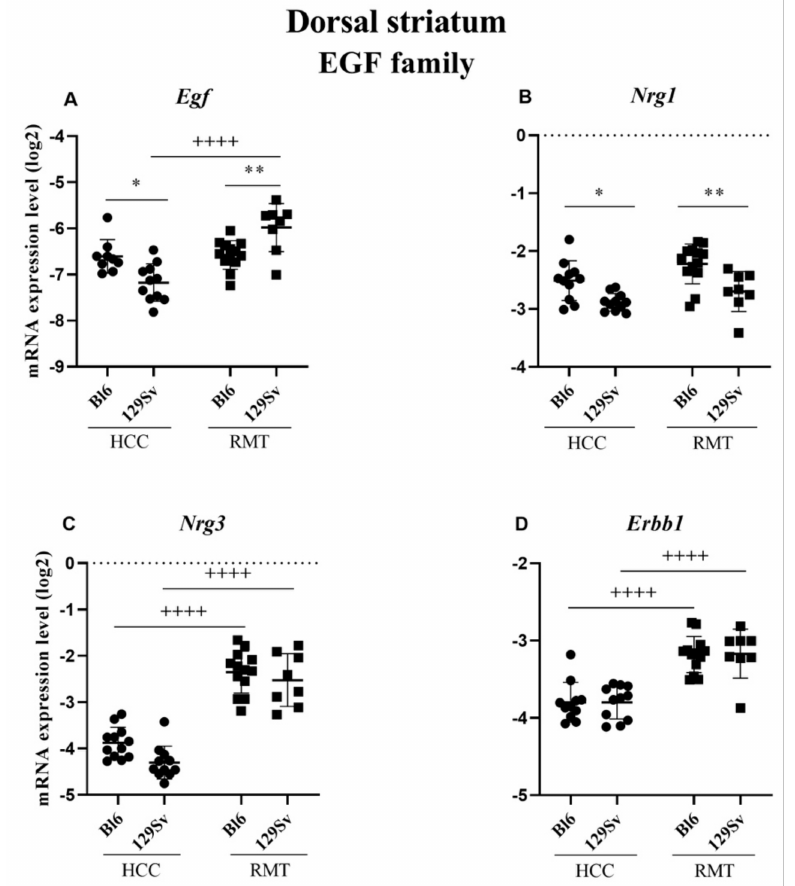
Figure 13. Egf family gene expression in dorsal striatum of Bl6 and 129Sv mice. Two-way ANOVA was applied to demonstrate differences between the strains and environments. Substantial statistically significant gene expressions for ( A ) Egf —epidermal growth factor, ( B ) Nrg1 —neuregulin 1, ( C ) Nrg3 — neuregulin 3 and ( D ) Erbb1 —epidermal growth factor receptor. Bonferroni post hoc test: * p ≤ 0.05 and ** p ≤ 0.01 compared to respective 129Sv mice, ++++ p ≤ 0.0001 in strain specific comparison. Data are expressed as mean values ± SD. Number of animals in each group varied from 8 to